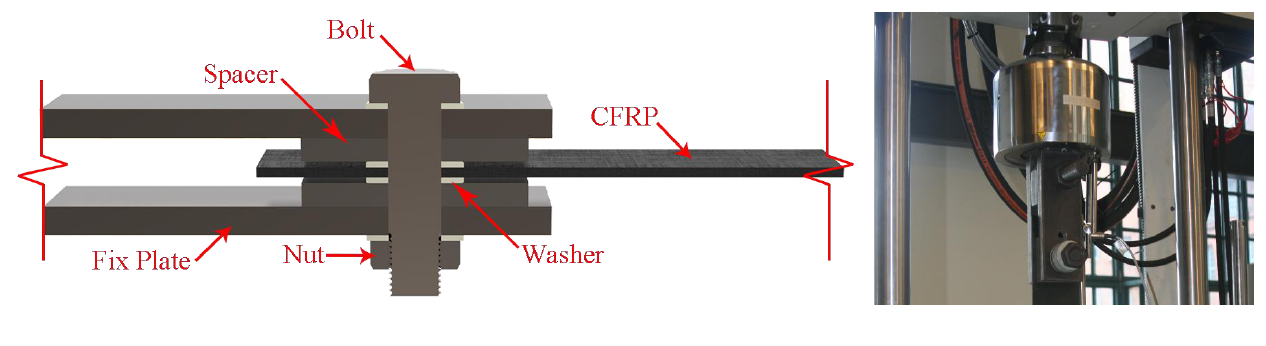
Figure 12. Part section view of the specimen and the experimental set-up.